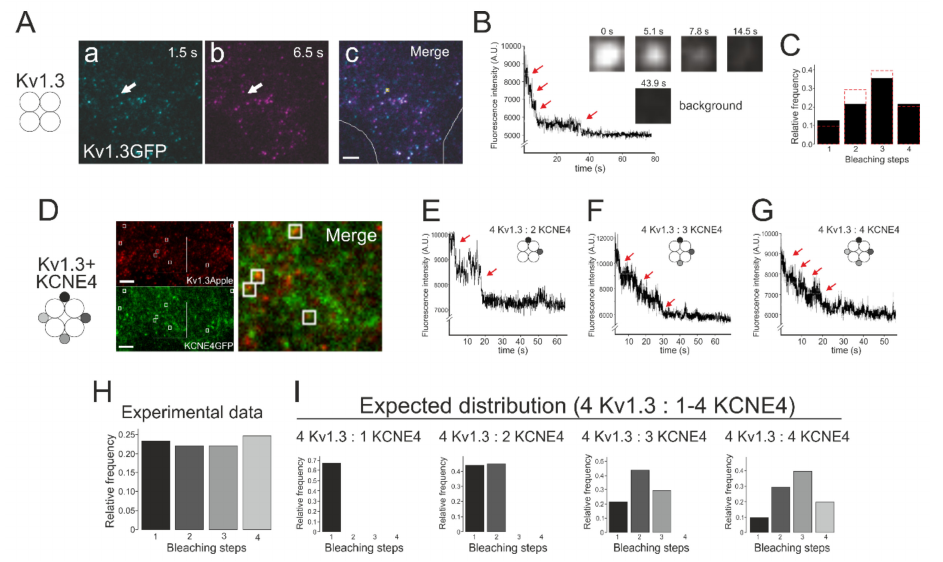
Figure 7. GFP bleaching steps from HEK-293 cells transfected with Kv1.3 in the absence or presence of KCNE4. ( A – C ) Cells were transfected with Kv1.3-loopBAD-GFP. ( A ) Representative 1.5 s and 6.5 s time-lapse snapshots from the TIRFM video (488 nm laser). White arrow heads (a, b) point to the yellow square ROI (6 × 6 pixels) in panel c. (a) Initial fluorescence intensity; (b) fluorescence intensity after the first bleaching step at the same spot; (c) merge image. Yellow square indicates the ROI. The white line delineates the cell shape. Scale bar, 5 µ m. ( B ) Representative graph of the bleaching steps for the di ff erent spots analyzed. Red arrows point to 4 bleaching steps. Squares, at the right, represent the fluorescence intensity after 4 consecutive bleaching steps at the same ROI. 0 s, initial fluorescence; 43.9 s, background intensity remaining after 4 consecutive bleaching steps. ( C ) Relative frequency of 1–4 bleaching events counted per spot. The black bars correspond to the experimental frequencies observed. Red dashed lines correspond to the theoretical distributions of bleaching steps with p = 0.67. ( D – G ) GFP bleaching steps from HEK-293 cells transfected with KCNE4-loopBAD-GFP and Kv1.3-Apple. ( D ) Representative snapshots from a cropped TIRF microscopy video. Upper panel (561 nm laser): Kv1.3-Apple. Lower panel (488 nm laser): KCNE4-loop-BADGFP. Merge panel zooms squares from previous panels. White squares ROIs (6 × 6 pixels) indicate colocalizing stationary spots. Putative oligomeric composition of the Kv1.3 / KCNE4 complex is represented with circles at the left. While 4 white circles indicate the Kv1.3 tetramer, KCNE4 units are represented with gray and black circles. ( E – G ) Representative graph of the GFP bleaching steps from the di ff erent spots analyzed. ( E ) Two bleaching steps indicating a 4:2 Kv1.3:KCNE4 stoichiometry. ( F ) Three bleaching steps